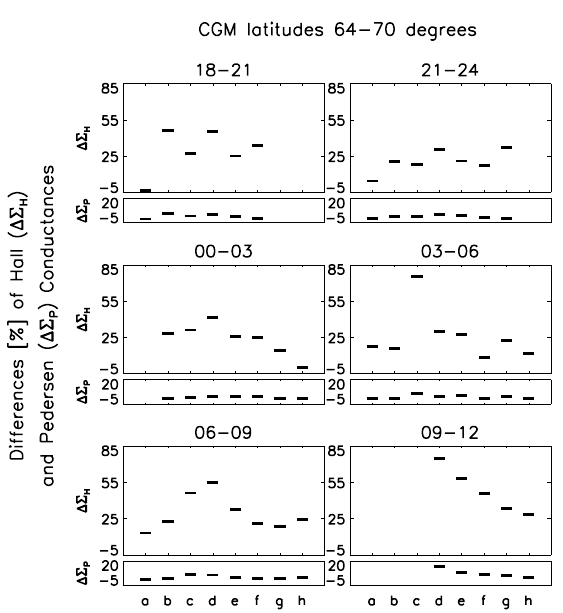
Fig. 3. Differences between conductances derived from the com- bined PIXIE and UVI measurements and conductances derived from UVI data only. We study six different MLT sectors for CGM latitudes 64–70 ◦ . The differences are given in percent. The letters a–h correspond to the 8 time periods given in Fig. 2.